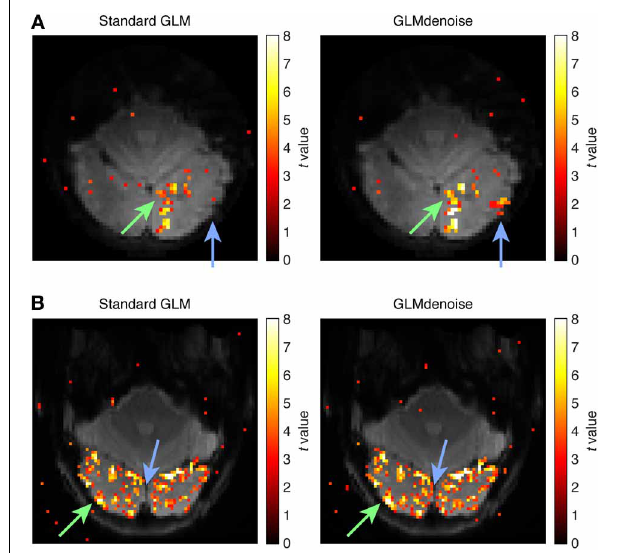
FIGURE 5 | Example activation maps. As an intuitive way to visualize SNR improvements, we show maps of t -values obtained using Standard GLM and maps obtained using GLMdenoise. Maps have been thresholded at t > 3 and are overlaid on the mean functional volume. (A) Activation map for dataset 3, slice 11, condition 31. The green arrow indicates an activated region that exhibits substantial increases in t -values when using GLMdenoise. The blue arrow indicates a region that exhibits activation under GLMdenoise but not under Standard GLM. (B) Activation map for dataset 7, slice 11, condition 24. Format same as (A)